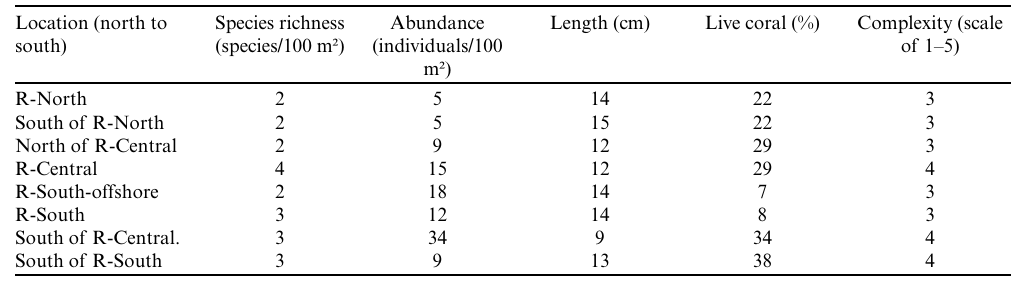
Table 1. Outcomes from field surveys covering eight sites in and around community-proposed reserve (R) locations. Results are means of richness, abundance, and length of fished species, as well as cover and complexity of coral reefs. Location (north to Species richness Abundance Length (cm) Live coral (%) Complexity (scale south) (species/100 m²) (individuals/100 of 1–5) m²) R-North 2 5 14 22 22